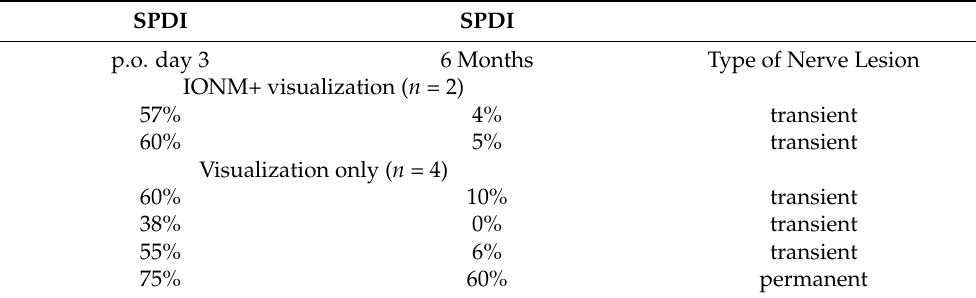
Table 2. Shoulder Pain and Disability Index (SPDI) in patients with temporary and permanent lesion of the accessory nerve following MRND with or without IONM. The index is reported as total SPDI score. The total SPDI score is the mean of the two subscales (Total pain score and Total disability score) and produces a total score ranging from 0 (best) to 100